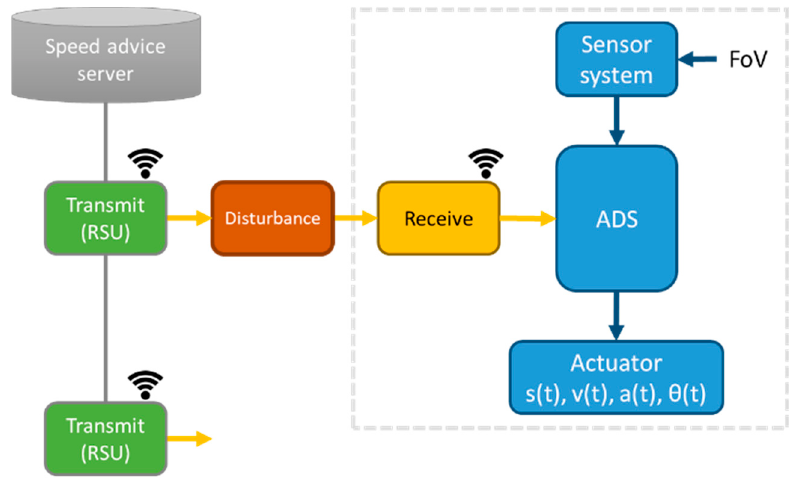
Figure 3. Input ‐ output scheme for a vehicle that receives speed advice messages from the infrastruc ‐ ture.